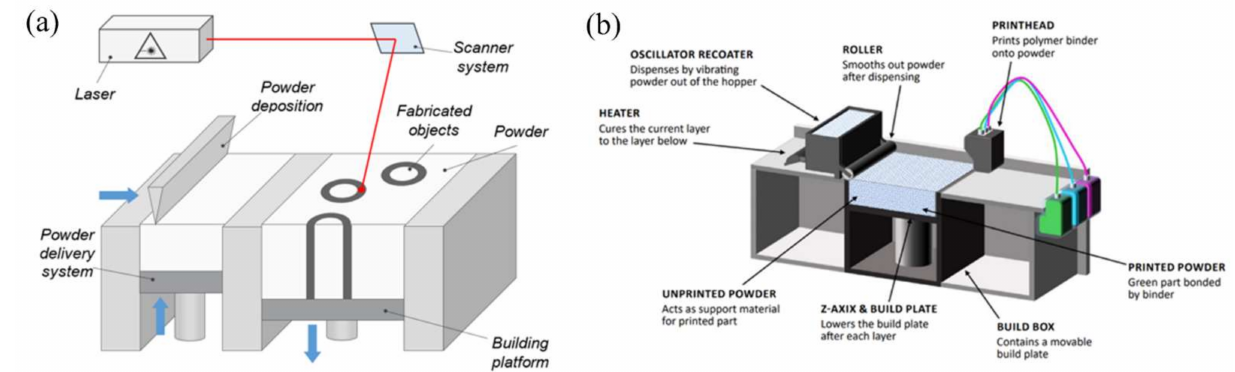
Figure 3. Powder-based metal AM techniques: ( a ) Powder Bed Fusion (PBF) [15]; ( b ) Binder Jetting